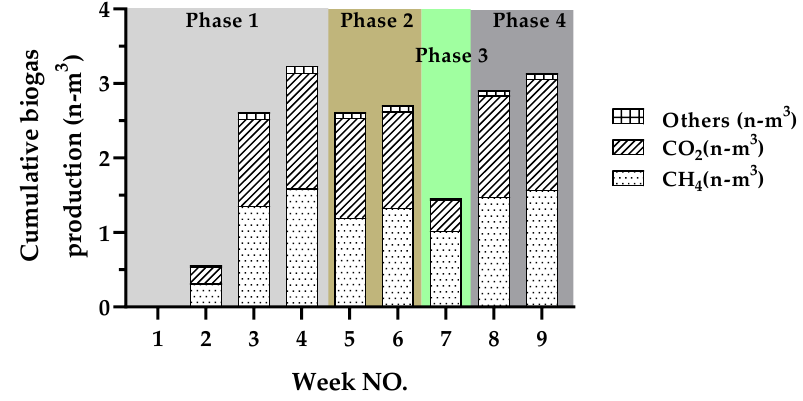
Figure 4. Weekly cumulative biogas production and methane concentration.